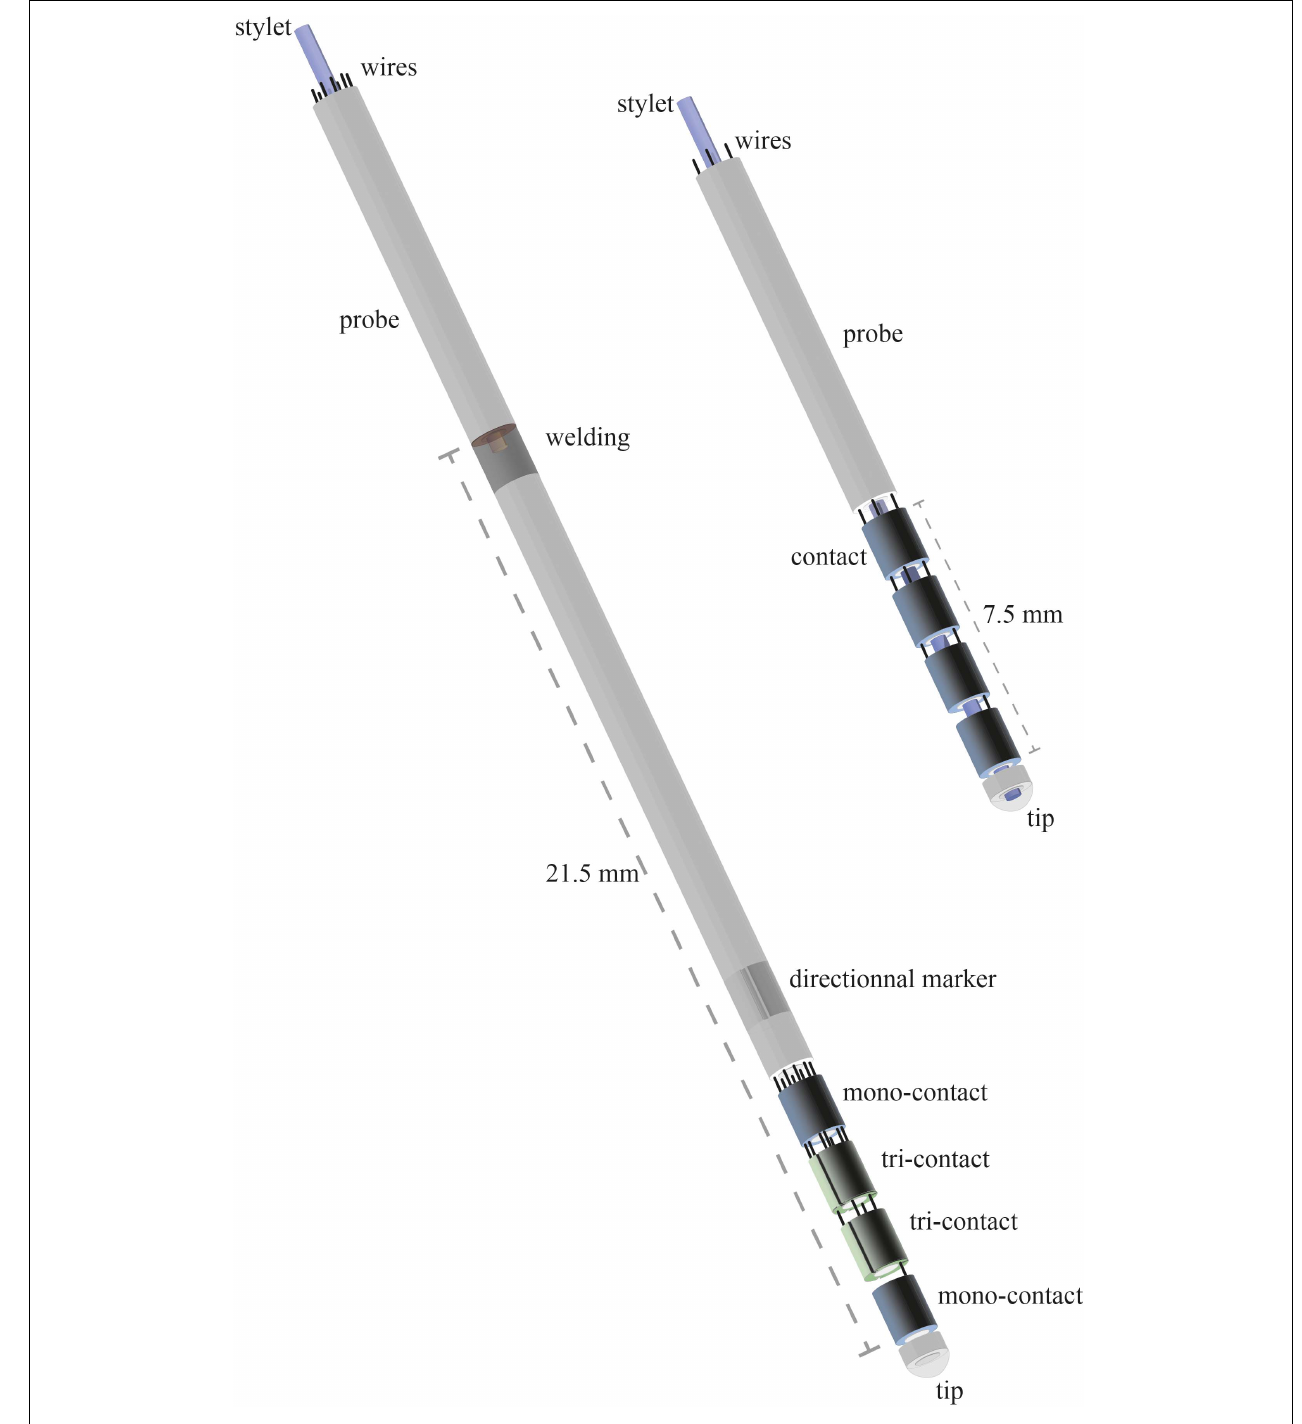
FIGURE 1 | Electrodes of deep brain stimulation. Directional (left) and non-directional (right) electrodes, with rigid distal parts measuring, respectively, 21.5 and 7.5 mm (see text methods for details).